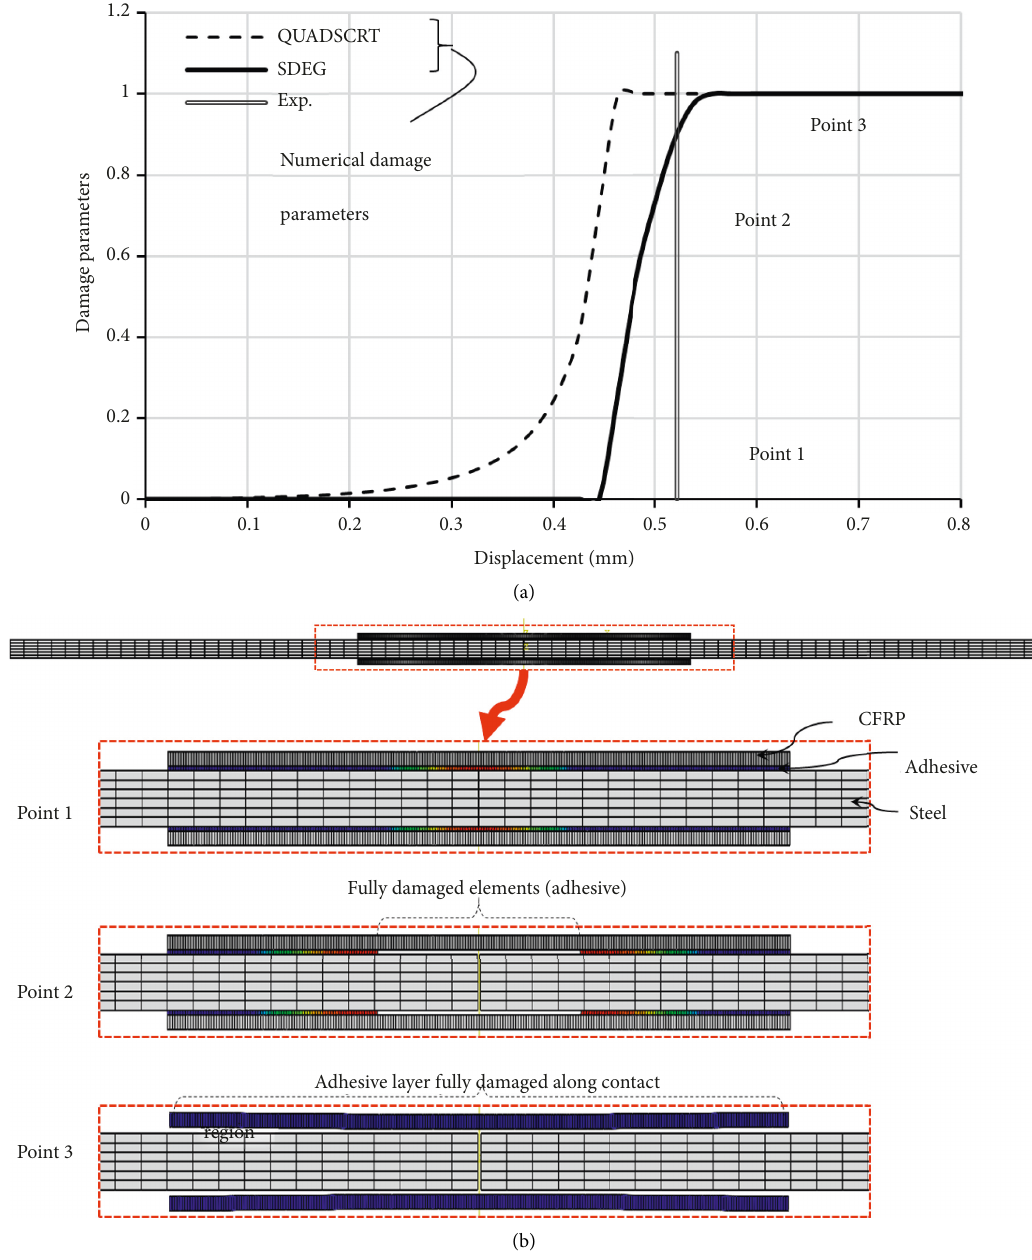
Figure 13: (a) Damage parameters vs. displacement; (b) physical damage in CFRP-steel joint under different displacement values, for specimen CF3-BL100. QUADSCRT � quadratic stress damage initiation criterion; SDEG � damage